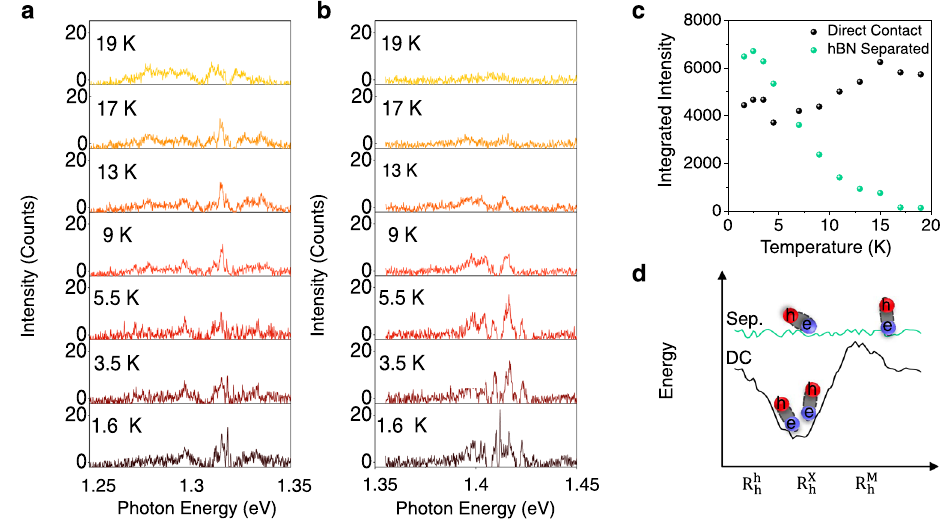
Fig. 4 | Temperature-dependent PL and origin of narrow IX lines. a PL of the narrow IX lines in the DC region as a function of temperature shows the width of individuallinesareincreasingby9Kanddisappearcompletelyby17K.Thesignalin the DC region includes narrow emission on top of a wider PL plateau. The wider emission persists to higher temperature (see Supplementary Fig. 6) that is con- sistent with previous temperature-dependent measurements on R-type hetero- structures. b Temperature-dependentPLfromthehBNseparatedregionshowsthe narrow lines are widening by 9K which is in good agreement with the DC region ’ s